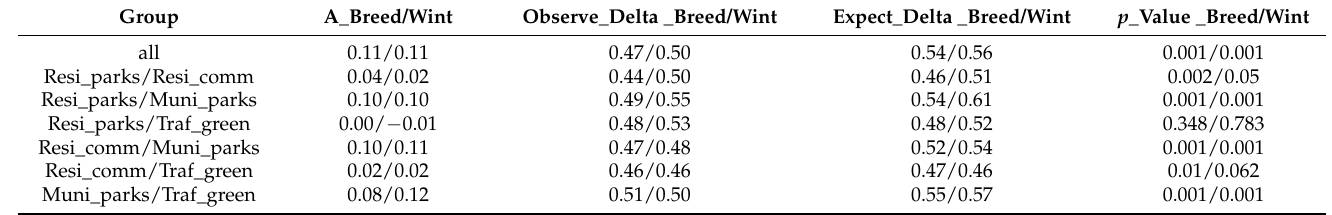
Table 2. Multi-response Permutation Procedures for analysis for all combinations of habitat